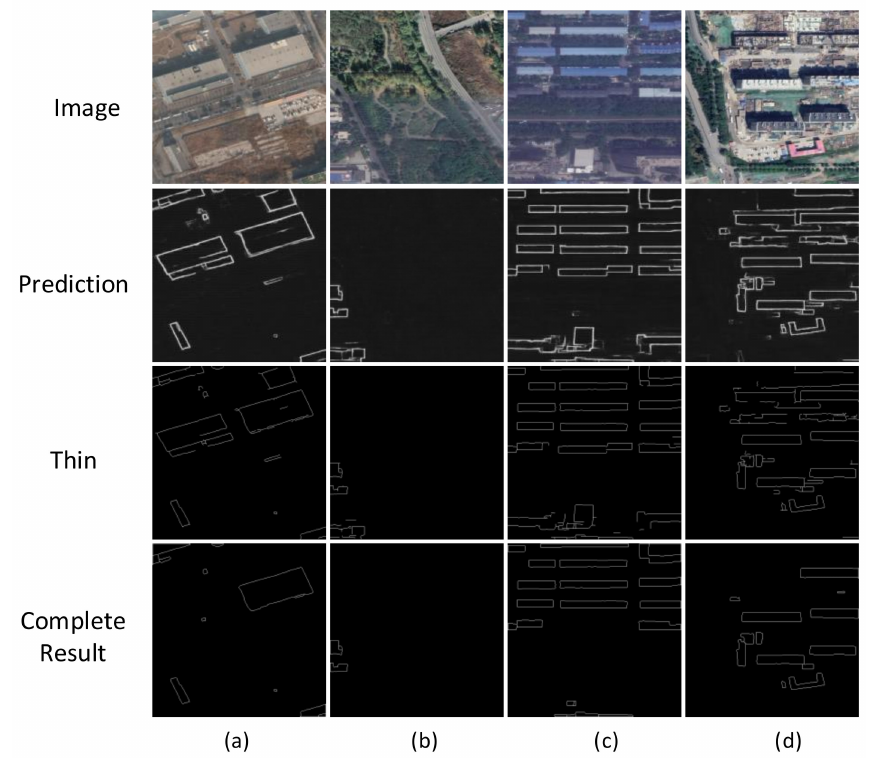
Figure 11. ( a – d ) are the results of building extraction for the fully supervised method with 50% samples in training distinctions. The image is the original image taken in Beijing from Google Earth. The prediction is the edge strength map, which is the result of the fully supervised method. The thin is the result of the prediction after binarization and thin. The complete result is the result of the thin after incomplete boundary